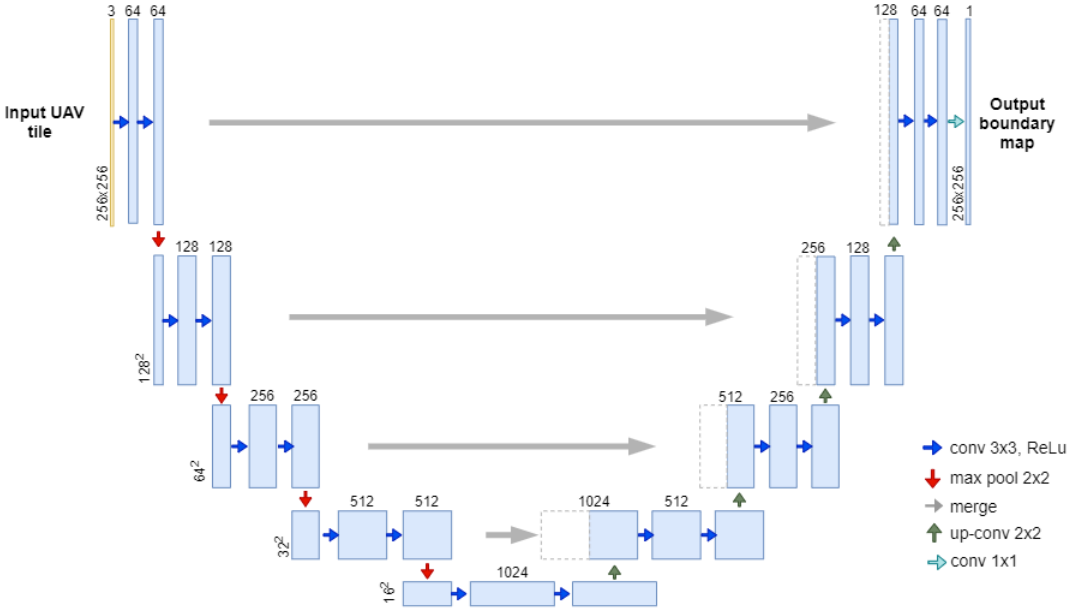
Figure 2. The implemented U-Net architecture (adapted from